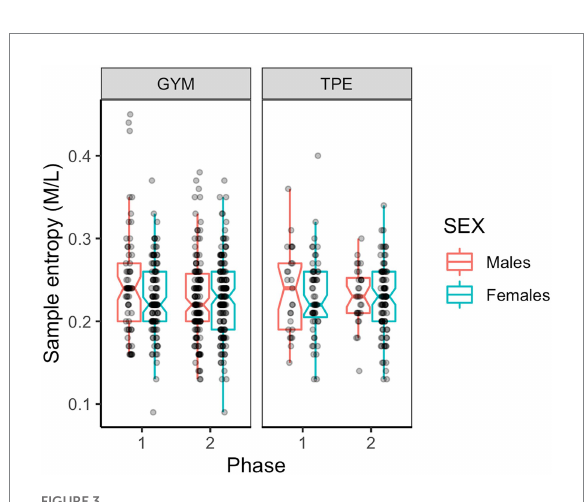
FIGURE 3 Mediolateral sample entropy for males and females in the GYM and TPE